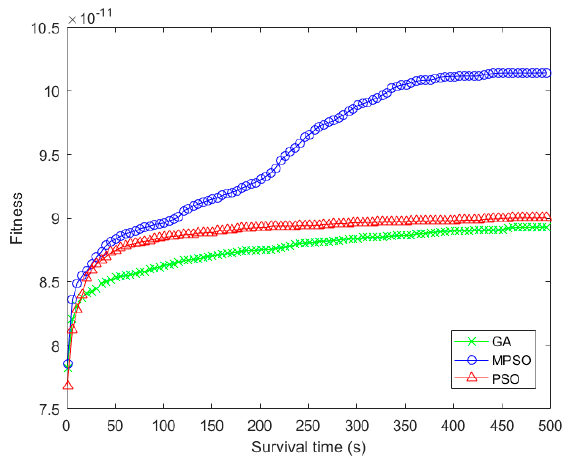
Figure 7. Comparison of fitness with the iteration times.